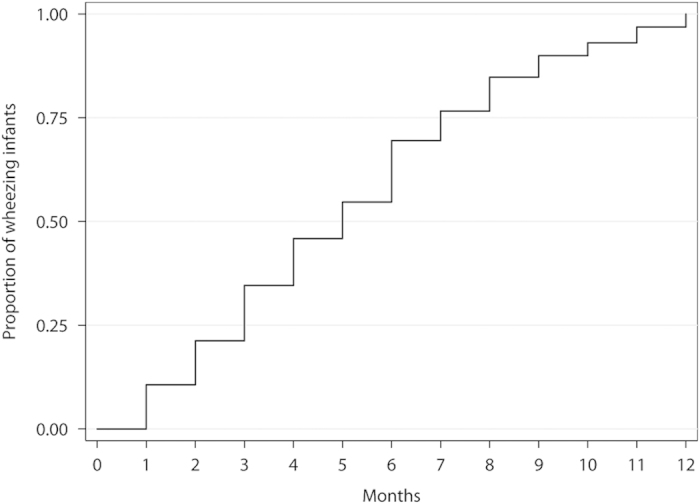
Proportion of wheezing infants by months.